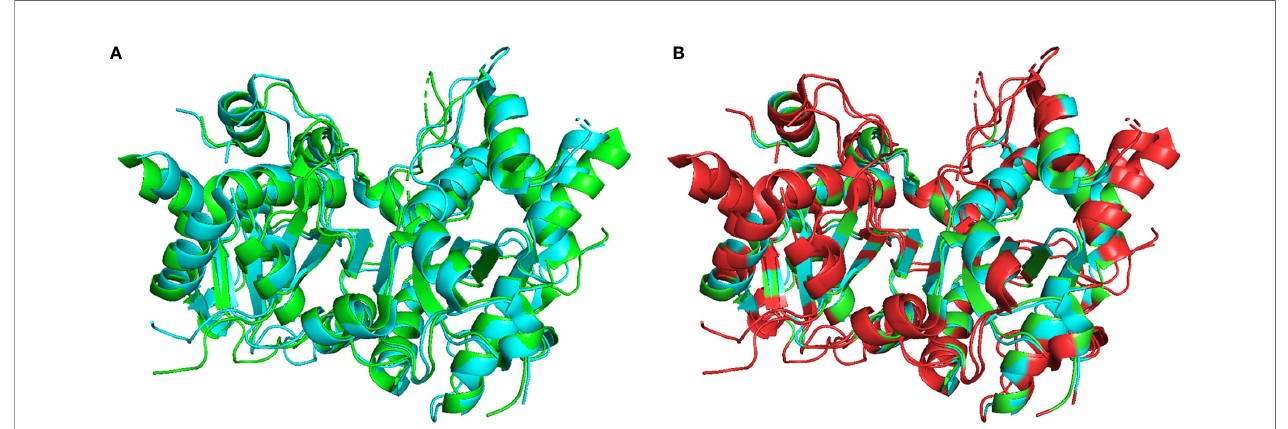
FIGURE 5 | Structural Comparison of TREX1 and TREX2. Graphic (A) shows structural alignment of mTREX1(1-242) and hTREX2 in cyan and green, respectively, and graphic (B) is the same alignment with discrepant residues colored red. Alignment and graphics were generated in PyMOL using the PDB structures 3MXJ and 1Y97 from refs